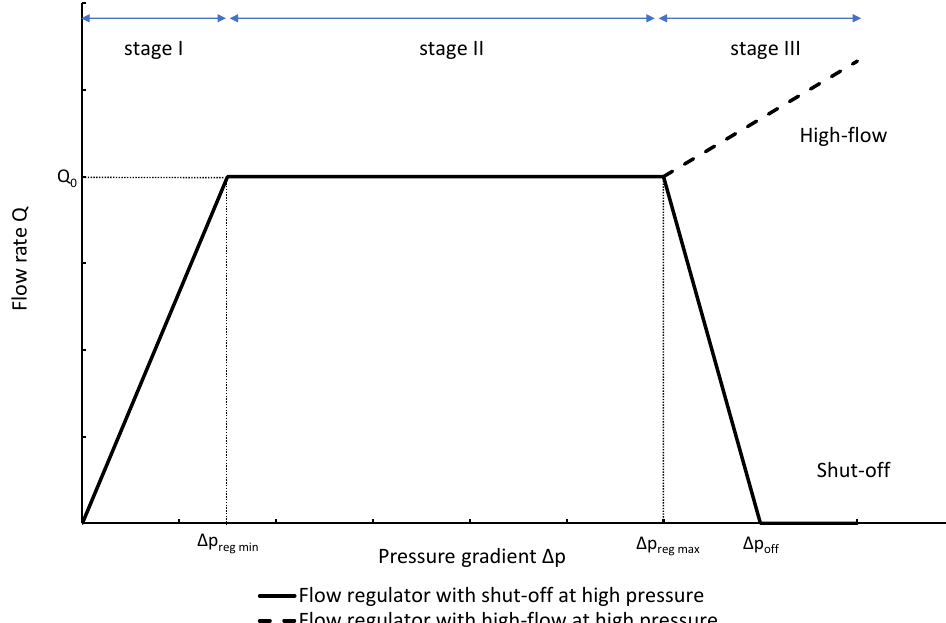
Figure 2. Ideal flow rate versus pressure gradient characteristic of a three-stage passive constant flow regulator. At low pressure (stage I), the regulator has a constant and low hydraulic resistance. In stage II, the flow is regulated at Q 0 for a pressure gradient in the range [∆P reg min ; ∆P reg max ]. At high pressure (stage III), the device could, according to its specific design, either stop the flow at ∆P off (solid line) or conversely, deliver a large flow rate (dashed line).